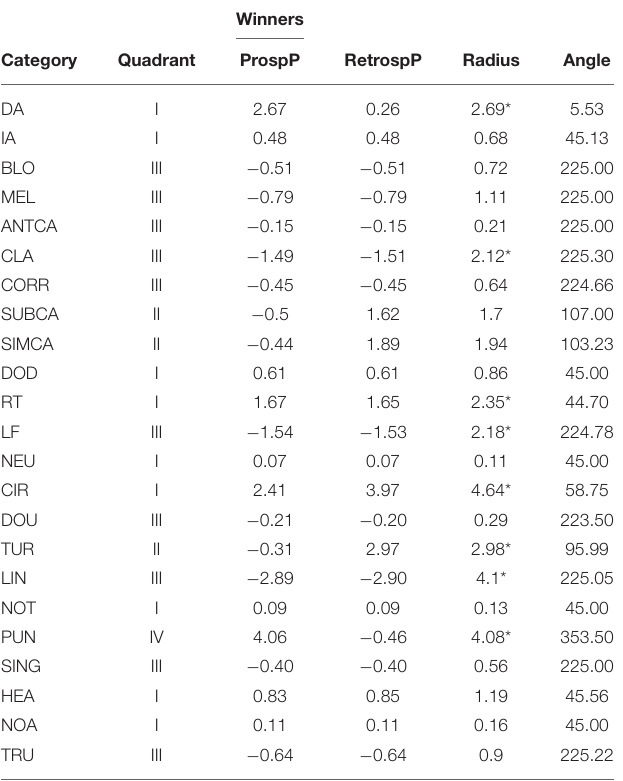
TABLE 9 | Results of the polar coordinate analysis for the 5P focal category in winners. Winners